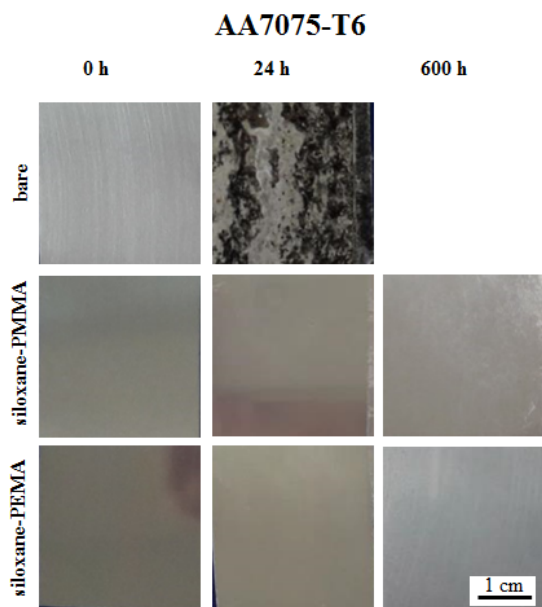
Figure 11. Images of bare and coated AA7075-T6 after 0, 24 and 600 h exposed to salt spray test (ASTM B117-07A).